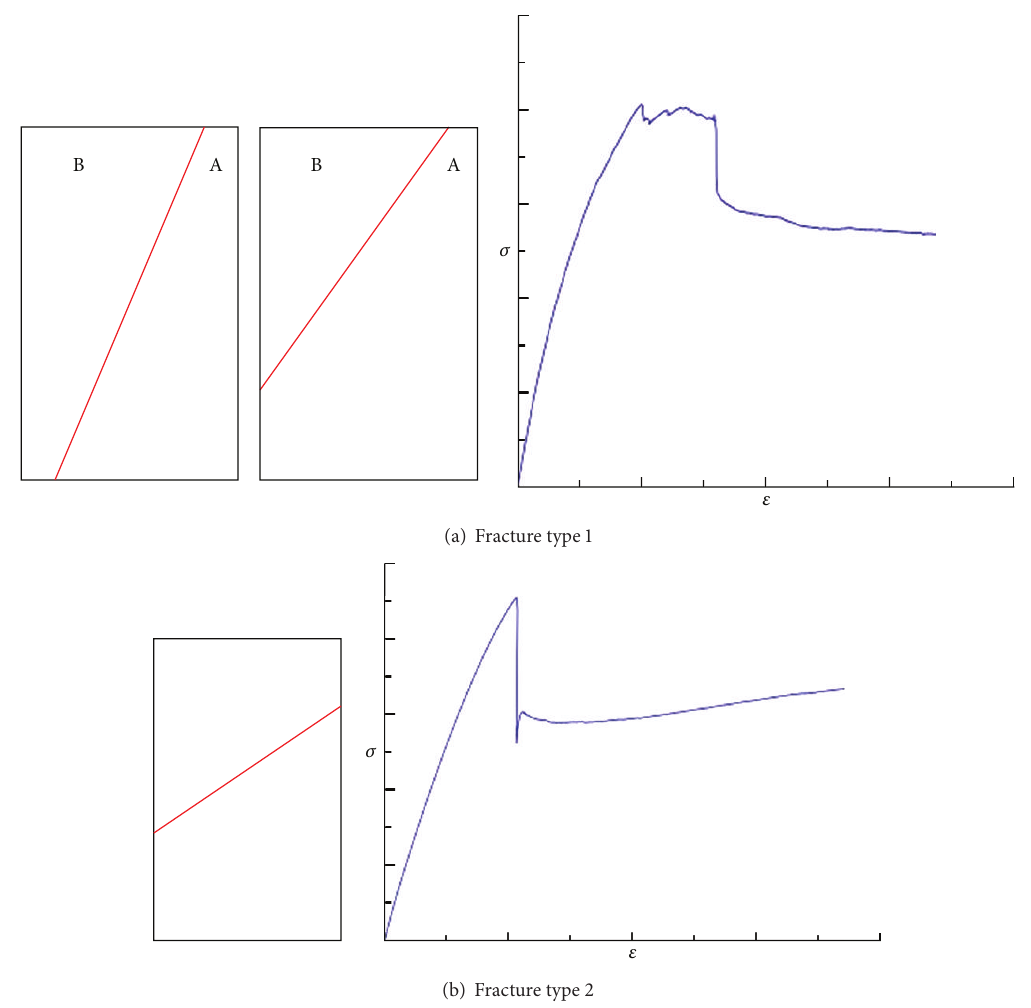
Figure 16: Type of